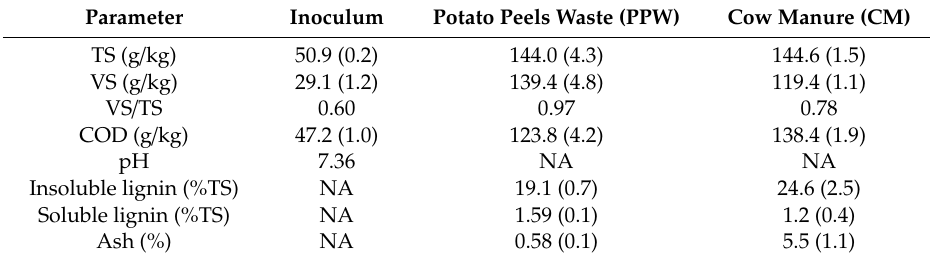
Table 2. Physical and chemical characteristics of the substrates used in the batch tests.